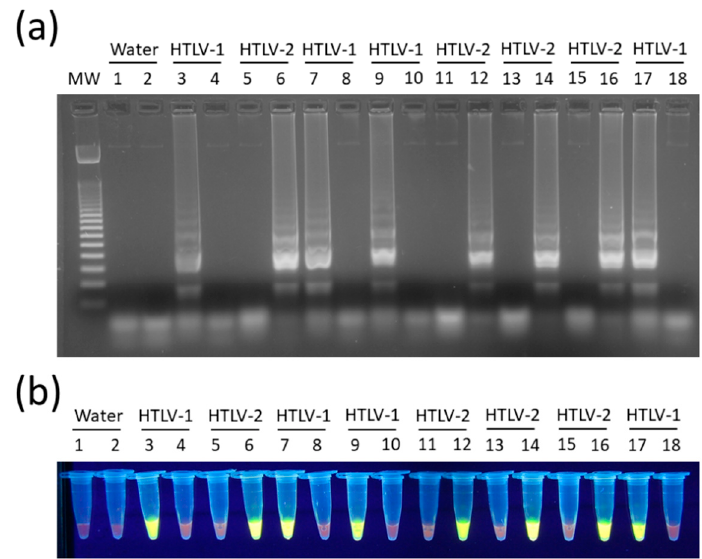
Figure 3. Optimization of magnesium and betaine concentrations in HTLV-1/2 LAMP assays. ( a ) HTLV-1 and ( b ) HTLV-2 LAMP assays were performed with MgSO 4 at concentrations of 3–6 mM. Betaine was tested at concentrations of 0.6 M to 1.2 M in assays for ( c ) HTLV-1 and ( d ) HTLV-2. Reactions were performed with 5 μ L of a 20 ng/ μ L DNA dilution, and 2 μ L of LAMP products were submitted to electrophoresis in 2% agarose gel in 1× Tris-Borate-EDTA (TBE) with 0.5× GelRed at 100 V for 1 h. MW, 100-bp DNA molecular weight. Lanes 1, 5, 9, and 13: no DNA template control (water). Lanes 2, 6, 10, and 14: HTLV-1/2 negative samples. Lanes 3, 4, 7, 8, 11, 12, 15, and 16: DNA samples positive for ( a , c ) HTLV-1 and ( b , d ) HTLV-2.